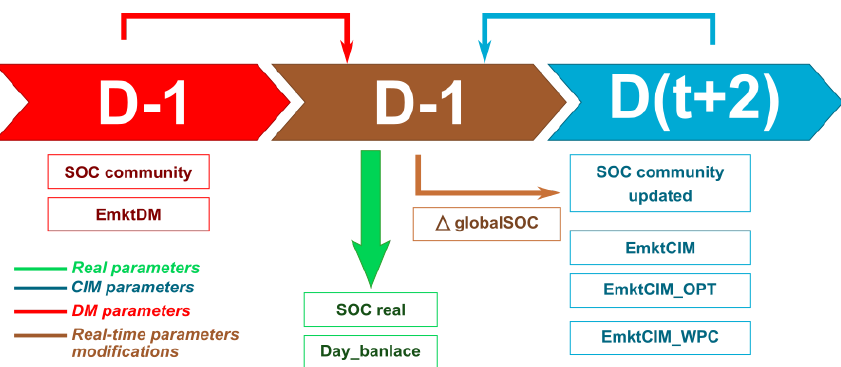
Figure 7. Variable communication between EMS stages.